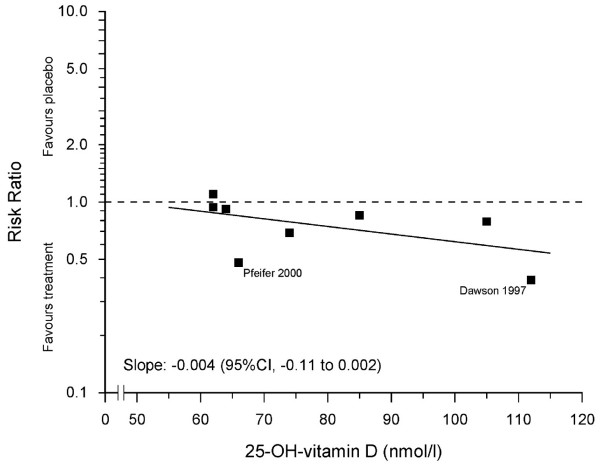
Risk ratios for any nonvertebral fracture according to achieved vitamin D level. Slope: slope of the regression line. 95%CI: 95 percent confidence interval. Pearson correlation coefficient: -0.54 (p = 0.17). Multiply values by 0.40 to convert 25-OH-vitamin D to ng/ml.